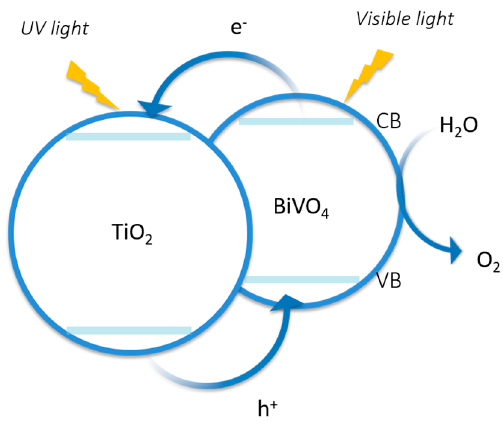
Figure 5. Schematic band gap alignment of S-doped, Fe-doped, and V-doped TiO 2 . Figure adapted from reference [158] of Babu et al. work.